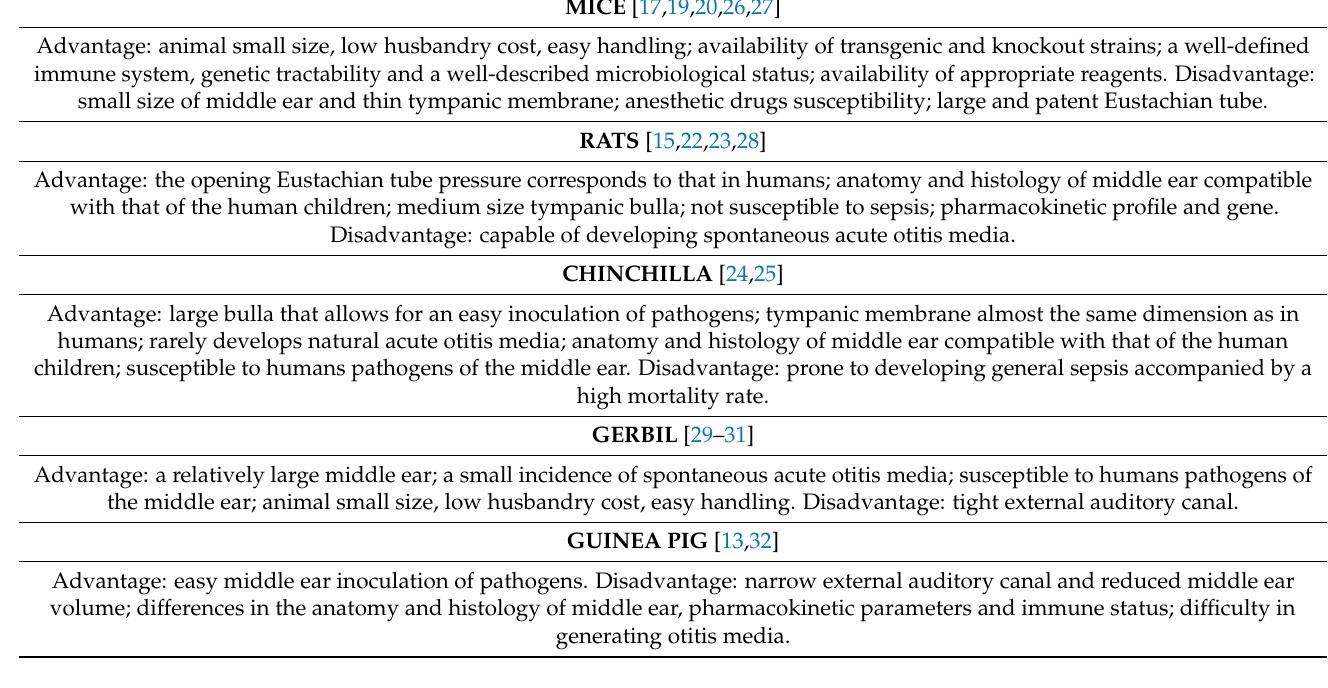
Table 1. The most common advantages and disadvantages of rodent species used in acute otitis media models. MICE